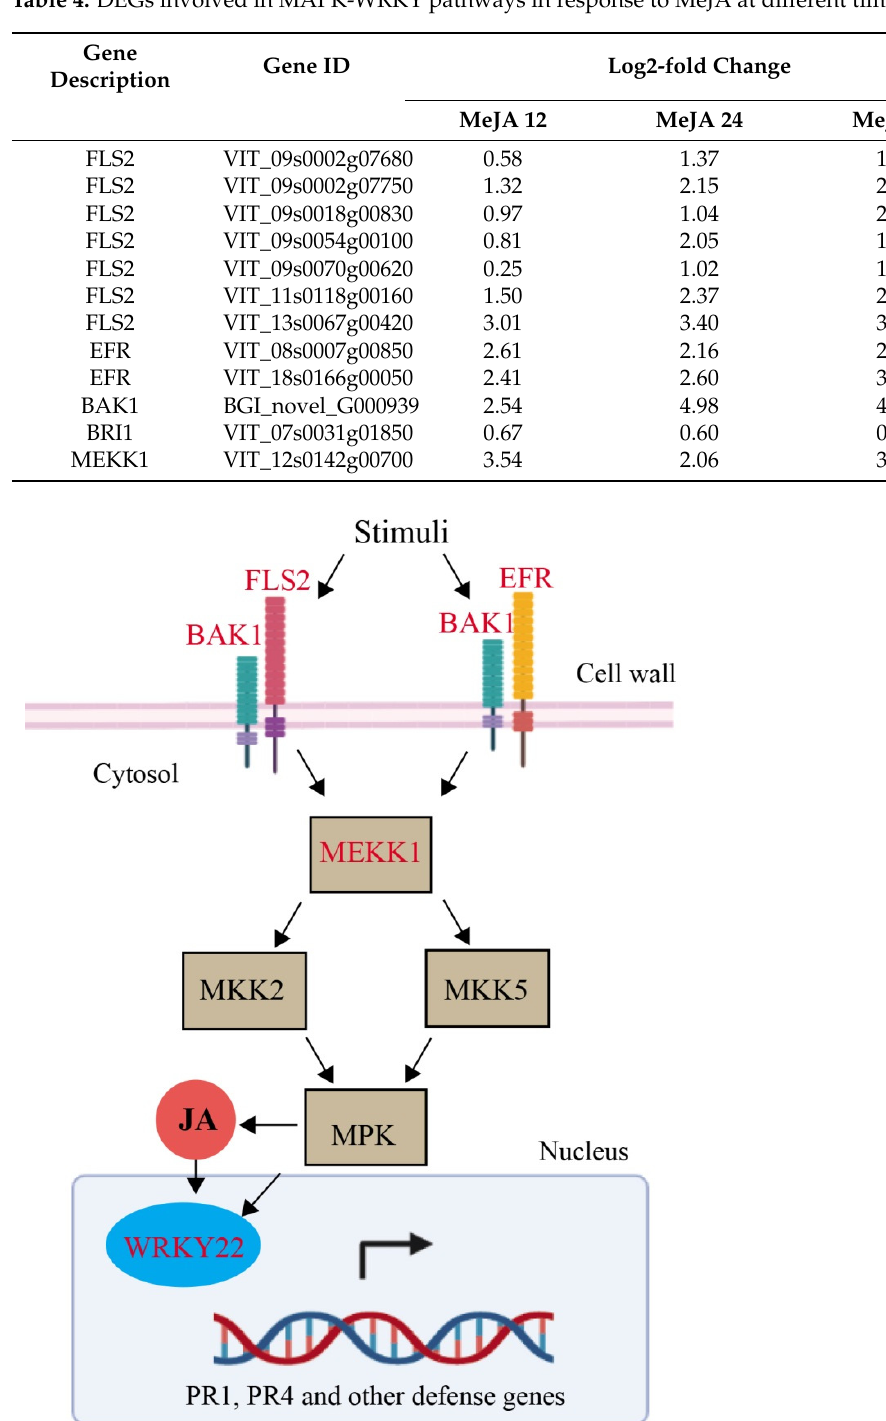
Table 4. DEGs involved in MAPK-WRKY pathways in response to MeJA at different time points.